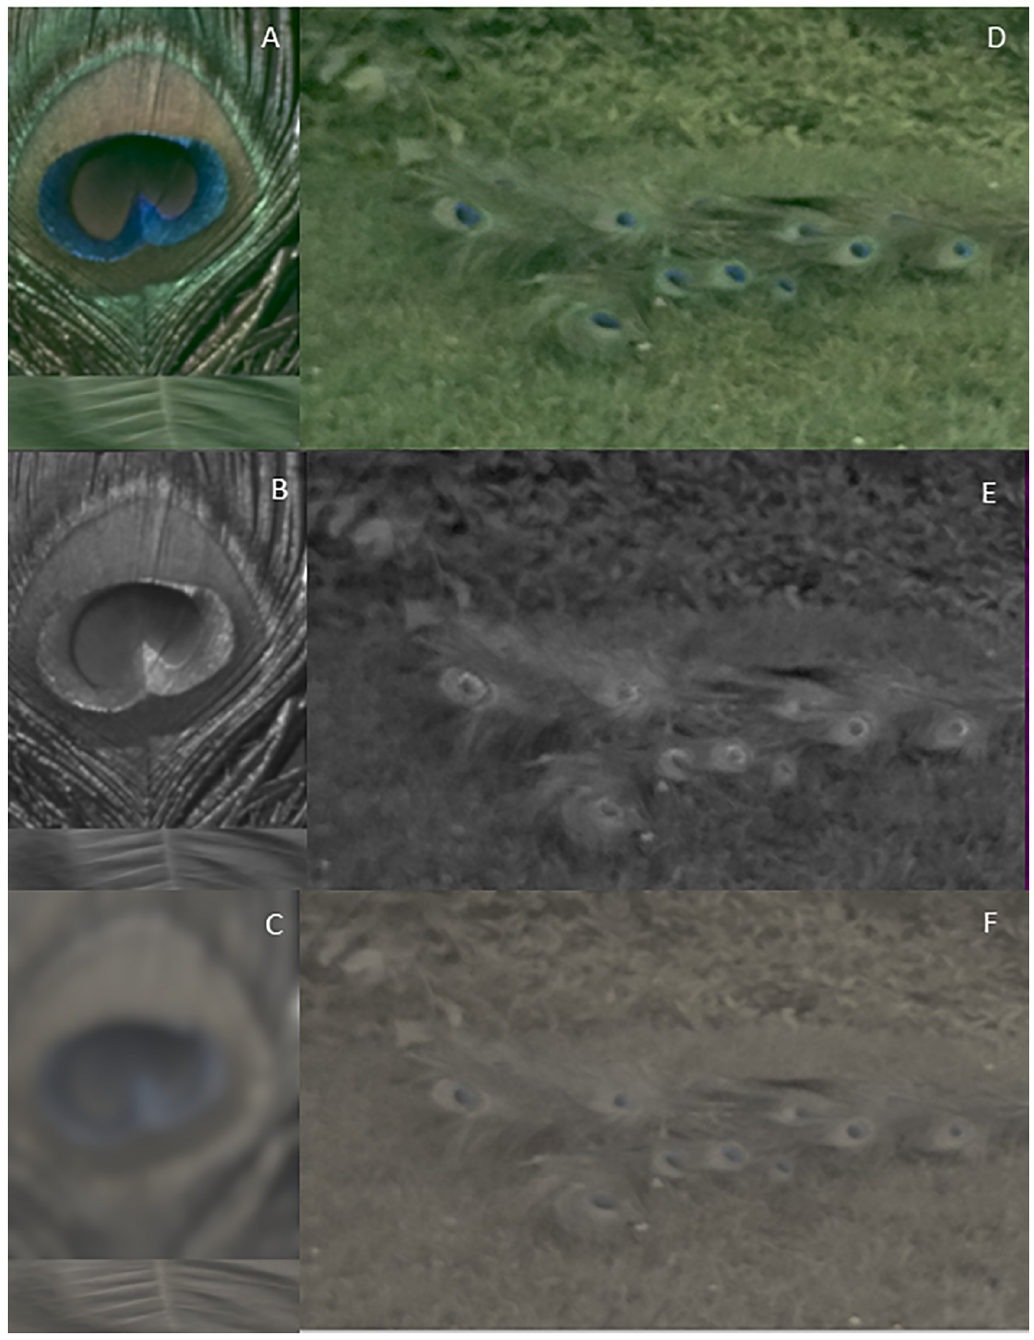
Fig 11. False color images of peacock eyespots for different visual models. At typical viewing distances during courtship displays, peacock eyespots have central features with brightness comparable to the surrounding rings in false color images for peafowl vision in the (A) LWS/MWS/SWS and (B) VS cone channels, as well as for dichromatic mammals (C). False color image of the model train at 2m in peafowl (D) LWS/MWS/SWS and (E) VS vision, and for (F) dichromatic mammalian vision show that the eyespots feature a darker pupil-like